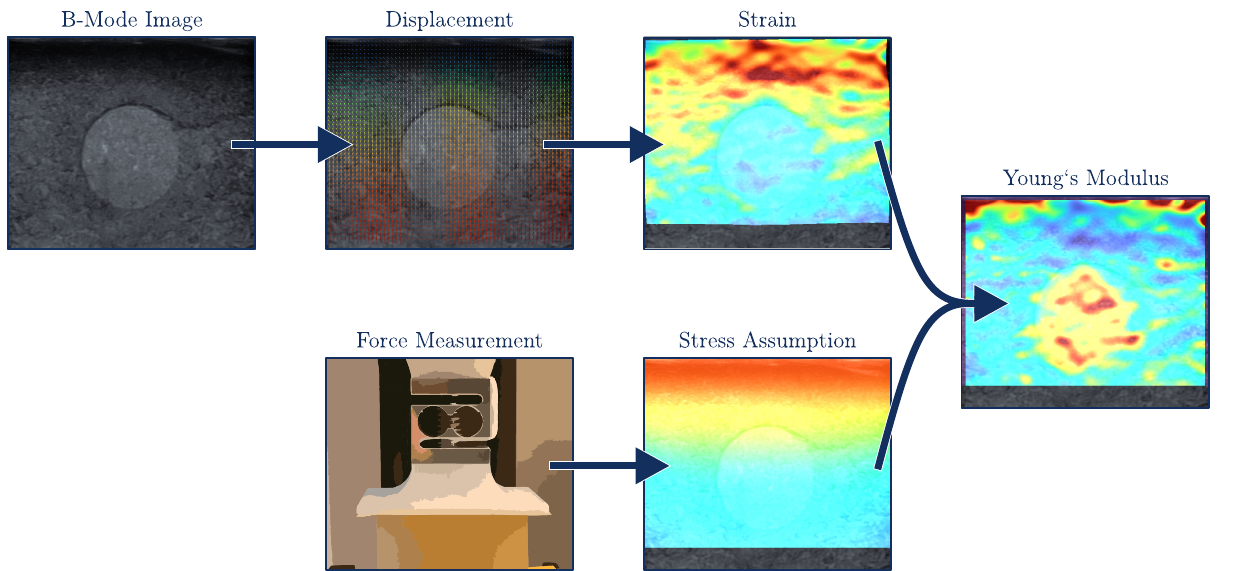
Figure 5. The workflow of the presented elastography algorithm with the basic steps: recording of the B-Mode images, displacement estimation, strain and stress calculation and, conclusively, computation of the Young’s